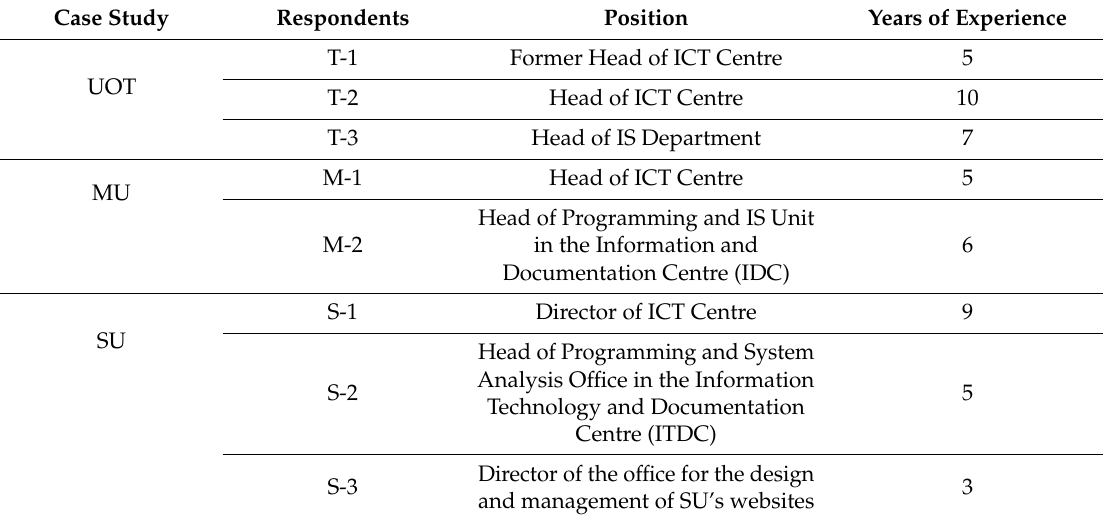
Table 1. Brief description of the respondents who participated in the